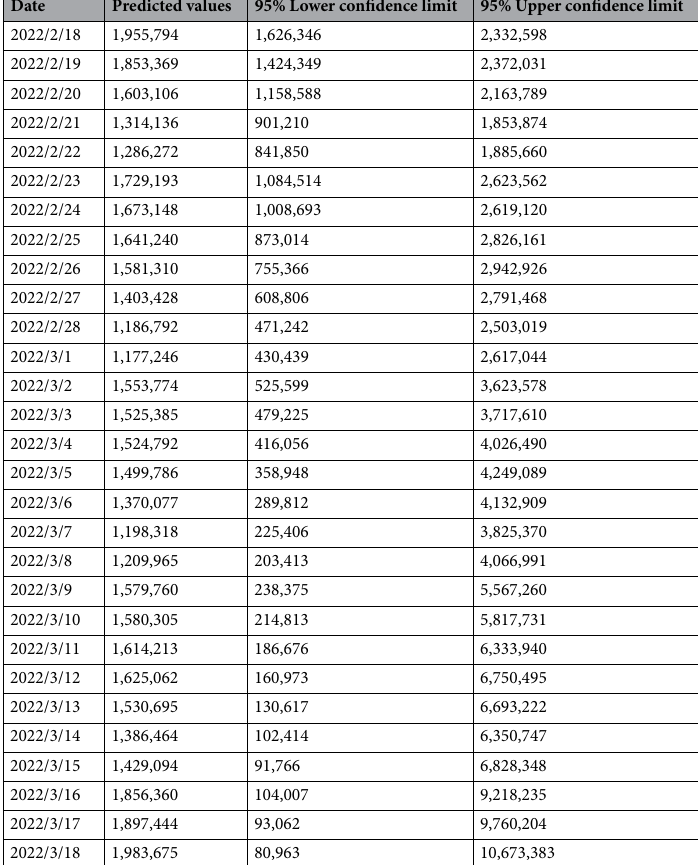
Table 6. Predictions of global daily confirmed COVID-19 cases by ARIMA(7,1,0)